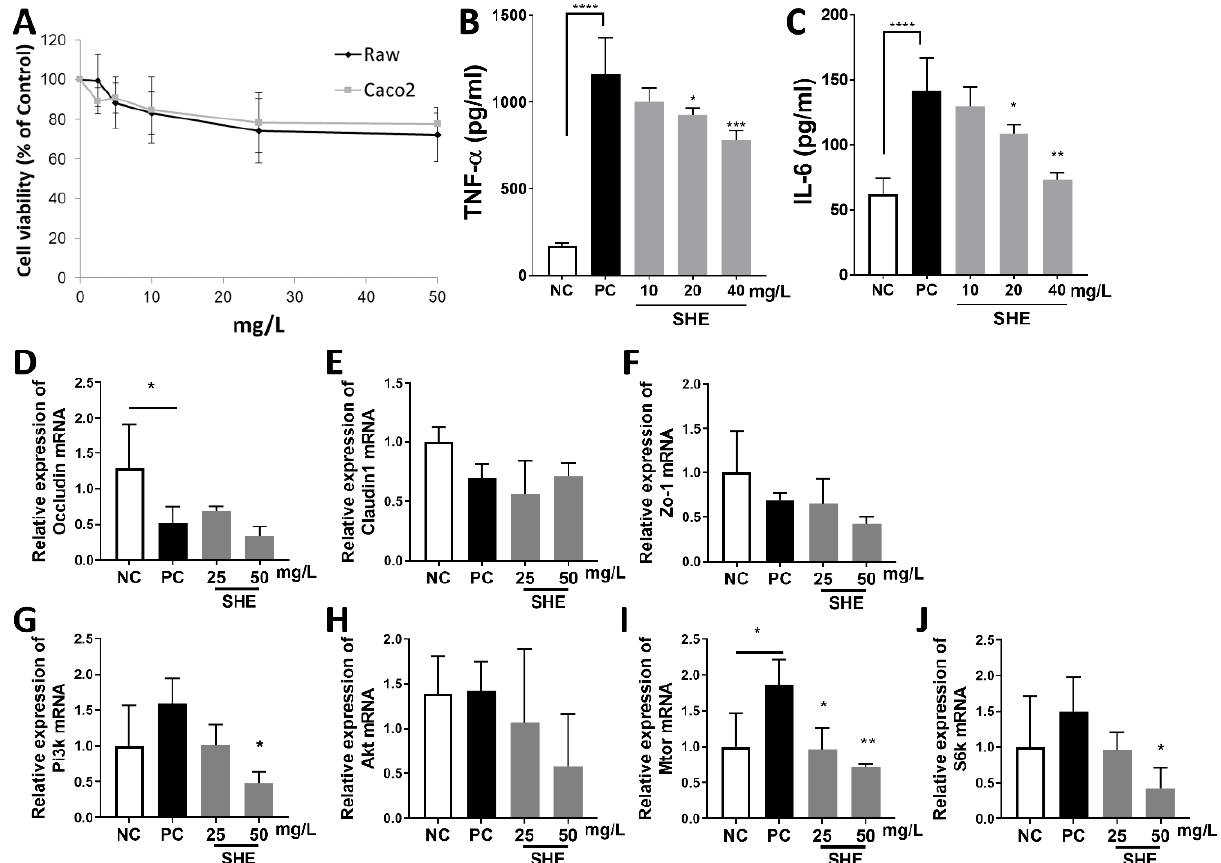
Figure 2. Effects of S. horneri extract (SHE) on LPS-treated RAW264.7 and Caco-2 cells. ( A ) The cytotoxicity of SHE (0–50 mg/L) on RAW264.7 and Caco-2 cells was estimated. ( B ) Levels of TNF- α and ( C ) IL-6 production in conditioned medium of RAW264.7 macrophages stimulated with LPS (50 ng/mL) for 4 h (TNF- α ) and 20 h (IL-6) with SHE (0–40 mg/L). Gene expressions of ( D ) Occludin , ( E ) Claudin1 , ( F ) Zo-1 , ( G ) Pi3k , ( H ) Akt , ( I ) Mtor , and ( J ) S6k mRNA in LPS (2 µ g/mL)-treated Caco-2 cells with SHE (0–50 mg/L). All data are expressed as means ± SD ( n = 4). * p < 0.05, ** p < 0.01, *** p < 0.001, **** p < 0.0001, significantly different compared with PC by one way ANOVA followed by Dunnett’s test. NC: negative control; PC: positive